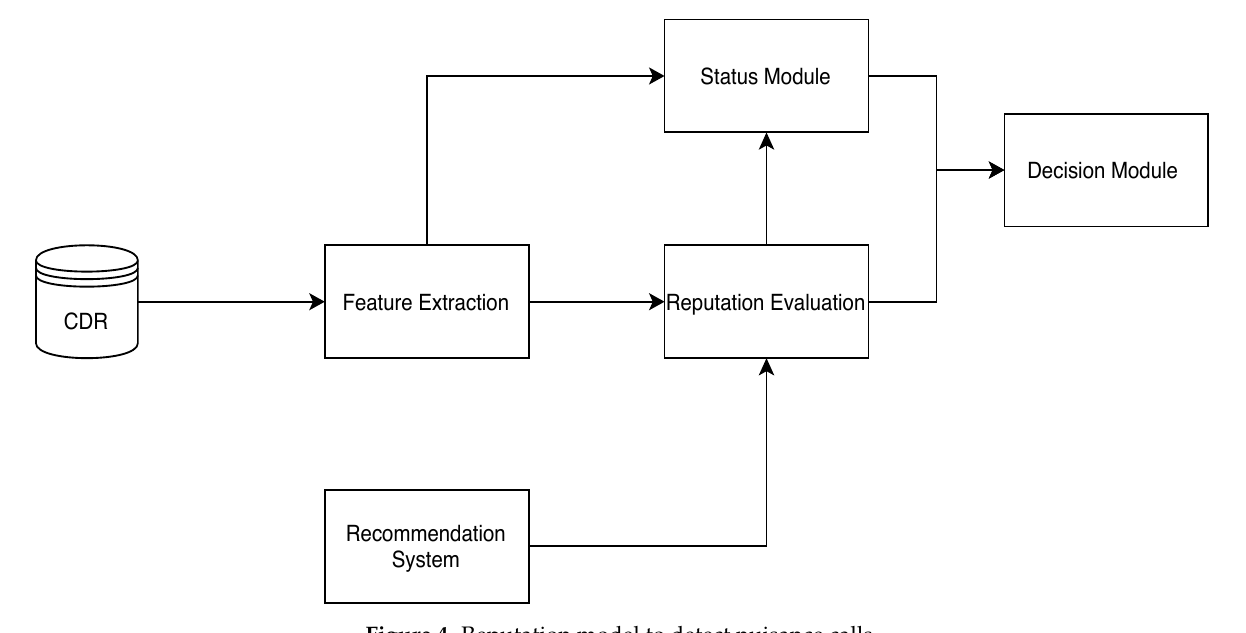
Figure 4. Reputation model to detect nuisance calls.